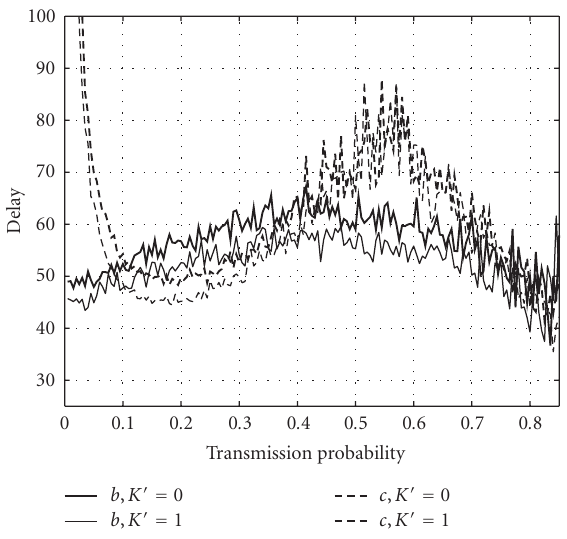
Figure 15: Delay of the dynamic ( K (cid:5) = 1) and static ( K (cid:5) = 0) cases for K = 4 (connections b and c of the asymmetric network of Figure 11).